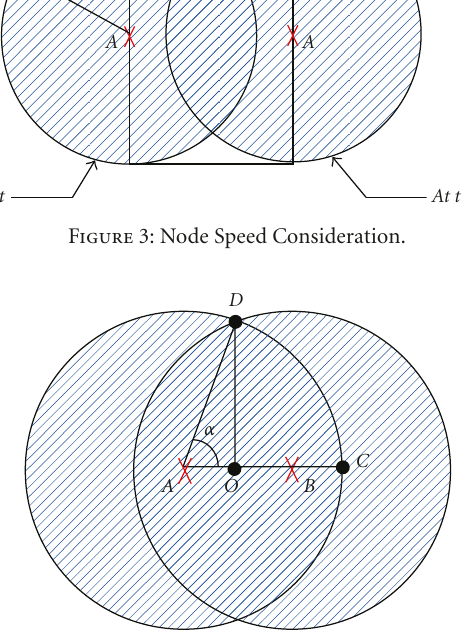
Figure 4: Message Utility